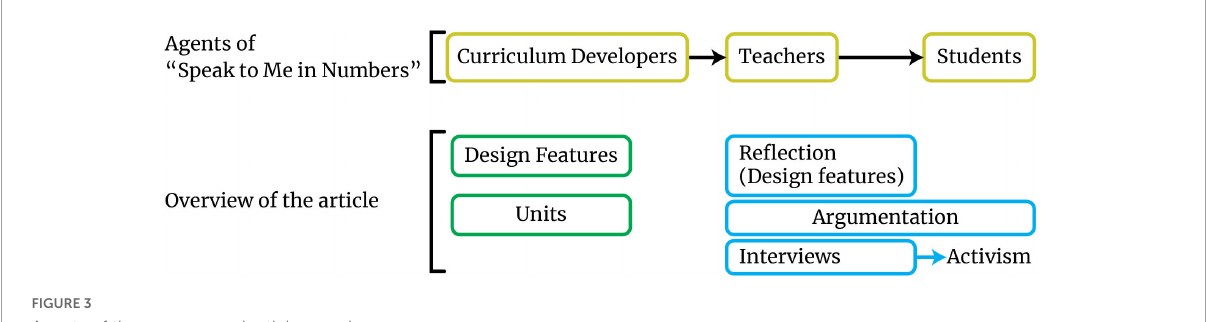
FIGURE3 Agents of the program and article